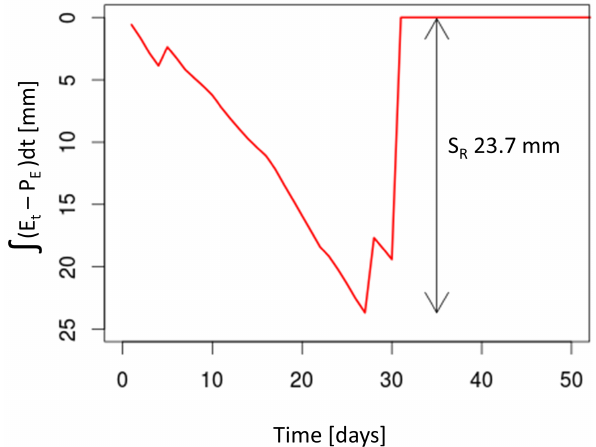
Figure 1. Derivation of root-zone storage capacity ( S R ) for one spe- cific time period in Hubbard Brook WS2 as difference between the cumulative transpiration ( E t ) and the cumulative effective precipi- tation ( P E )